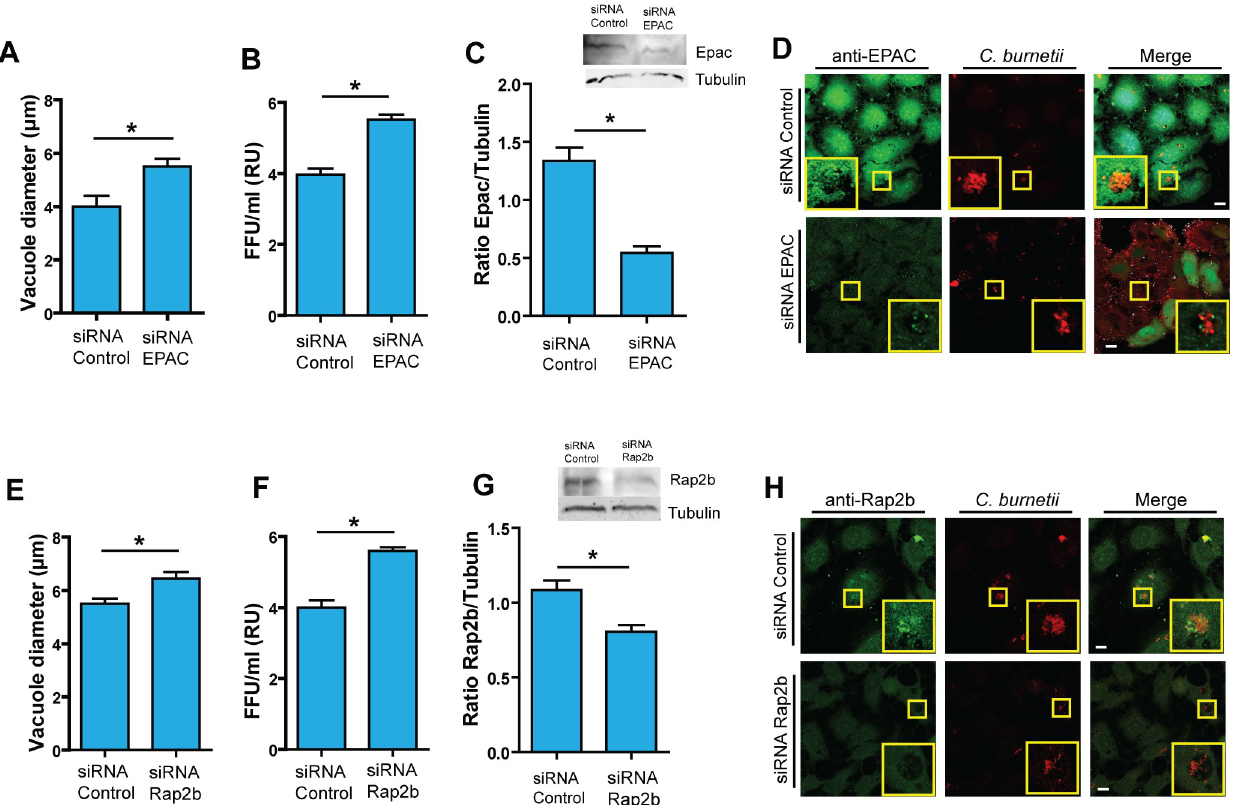
Fig 3. The knockdown of EPAC or Rap2b alters development of the Coxiella vacuole. A. Hela cells were transfected with siRNA against EPAC or an irrelevant siRNA as negative control. After 48 h, cells were transfected for a second time, infected with C . burnetii and cultured for an additional 48 h period to allow the development of the large C . burnetii vacuole (MOI = 10). Subsequently, cells were fixed and subjected to indirect immunofluorescence for the detection of both EPAC and Coxiella using specific antibodies. Images were captured by confocal microscopy. Quantification of the vacuole diameter in cells depleted for EPAC compared with the control condition. Data represent the mean ± SEM of at least three independent experiments in which at least 200 vacuoles were scored in each experiment. p � 0.01 Data represent the mean ± SEM of at least two independent experiments. B. HeLa cells were transfected with siRNA against EPAC or an irrelevant siRNA as negative control. After 48 h, cells were transfected for a second time, infected with C . burnetii and cultured for an additional 48 h period to allow the development of the large C . burnetii vacuole. The cells were then lysed by sonication and the supernatant was diluted (1:100) and used to infect Vero cells. After 72 h of incubation (chase), cells were fixed and examined by fluorescence microscopy. Data represent the mean ± SEM of at least three independent experiments where a minimum of 1,000 cells were scored in each experiment ( � p � 0.05.). C. Western blot of the assay described in A and quantification of intensity of the EPAC bands relative to tubulin. D. HeLa cells were transfected with a siRNA against EPAC or an irrelevant siRNA as negative control. After 48 h, cells were transfected for a second time, infected with C . burnetii and cultured for an additional 48 h period. Subsequently, cells were fixed and subjected to indirect immunofluorescence for the detection of both EPAC and Coxiella using specific antibodies. Images were captured by confocal microscopy. The panels show that in cells treated with siRNA there is an absence of EPAC labeling in cells indicating that EPAC was effectively depleted. E . HeLa cells were transfected with siRNA against Rap2b or an irrelevant siRNA as negative control. After 48 h, cells were transfected for a second time, infected with C . burnetii and cultured for an additional 48 h period to allow the development of the large C . burnetii vacuole (MOI = 10). Subsequently, cells were fixed and subjected to indirect immunofluorescence for the detection of both Rap2b and Coxiella using specific antibodies. Images were captured by confocal microscopy. Quantification of the vacuole diameter in cells depleted for Rap2b compared with the control condition. Data represent the mean ± SEM of at least three independent experiments in which at least 200 vacuoles were scored in each experiment. p � 0.01 Data represent the mean ± SEM of at least two independent experiments. F. HeLa cells were transfected with siRNA against Rap2b or an irrelevant siRNA as negative control. After 48 h, cells were transfected for a second time, infected with C . burnetii and cultured for an additional 48 h period to allow the development of the large C . burnetii vacuole. The cells were then lysed by sonication and the supernatant was diluted (1:100) and used to infect Vero cells. After 72 h of incubation (chase), cells were fixed and examined by fluorescence microscopy. Data represent the mean ± SEM of at least three independent experiments where a minimum of 1,000 cells were scored in each experiment ( � p � 0.05.). G. Western blot of the assay described in D and quantification of intensity of the Rap2b bands relative to tubulin. H. HeLa cells were transfected with siRNA against Rap2b or an irrelevant siRNA as negative control. After 48 h, cells were transfected for a second time, infected with C . burnetii and cultured for an additional 48 h period. Subsequently, cells were fixed and subjected to indirect immunofluorescence for the detection of both Rap2b and Coxiella using specific antibodies. Images were captured by confocal microscopy. The panels show that in cells treated with siRNA there is an absence of Rap2b labeling in cells indicating that Rap2b was effectively